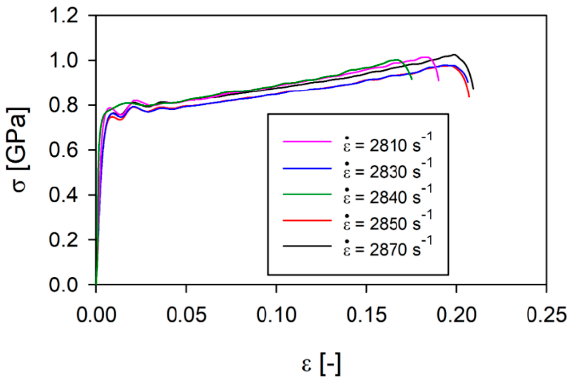
Figure 2. True stress–strain curves of 316L alloy made by LENS technology at an average strain rate of 2840 s − 1 . Table 3. Proof stress values for selected of the 316L alloy made by LENS technology. Sample No.